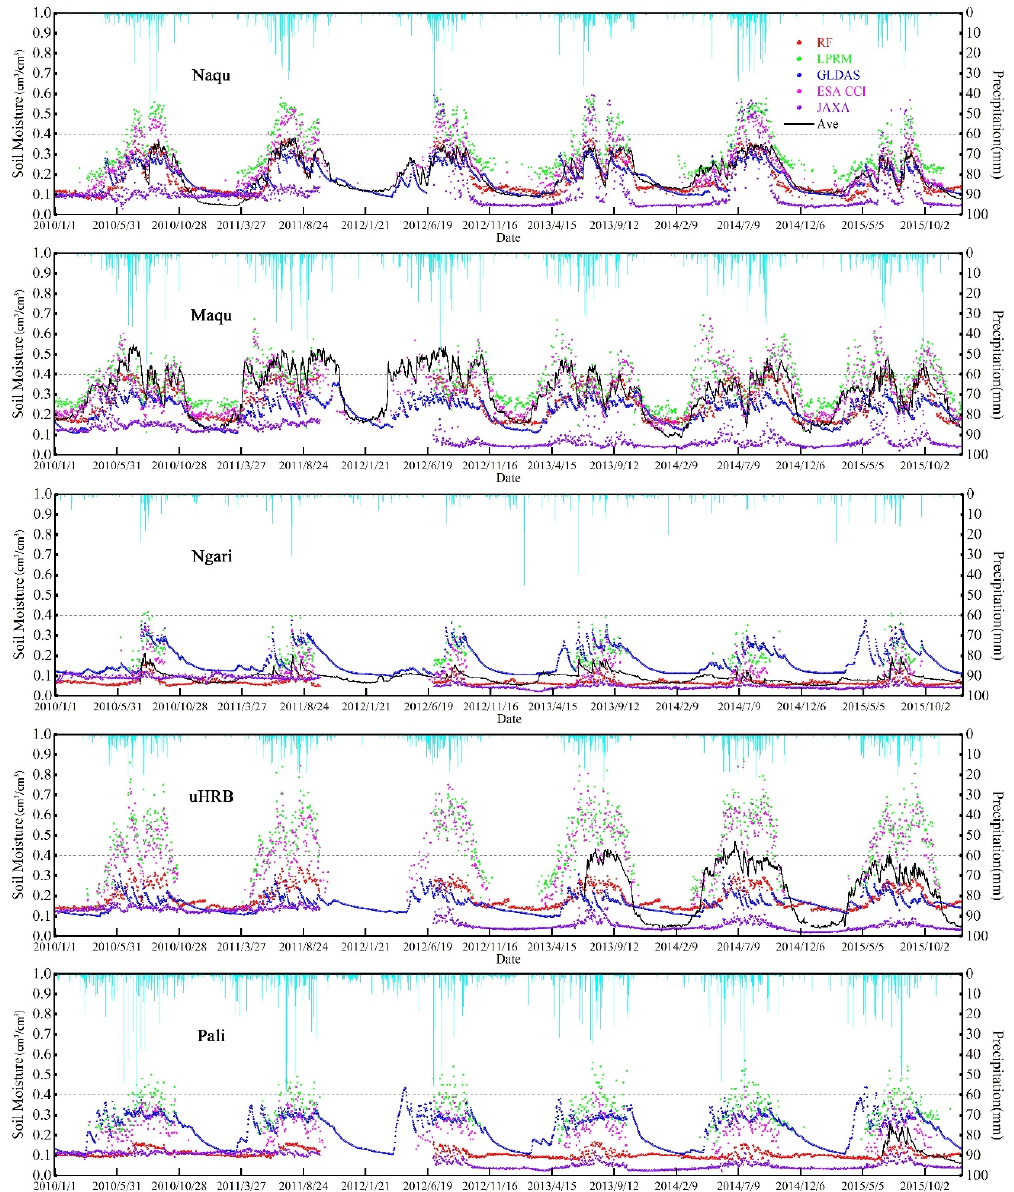
Figure 6. Time series of in situ network data, RFSM and Japan Aerospace Exploration Agency (JAXA), land surface parameter model (LPRM), European Space Agency’s Climate Change Initiative (ESA CCI) and Global Land Data Assimilation System (GLDAS) over a time period (2010–2015): Naqu, Maqu, Ngari, upper reach of the Heihe River Basin (uHRB) and Pali.